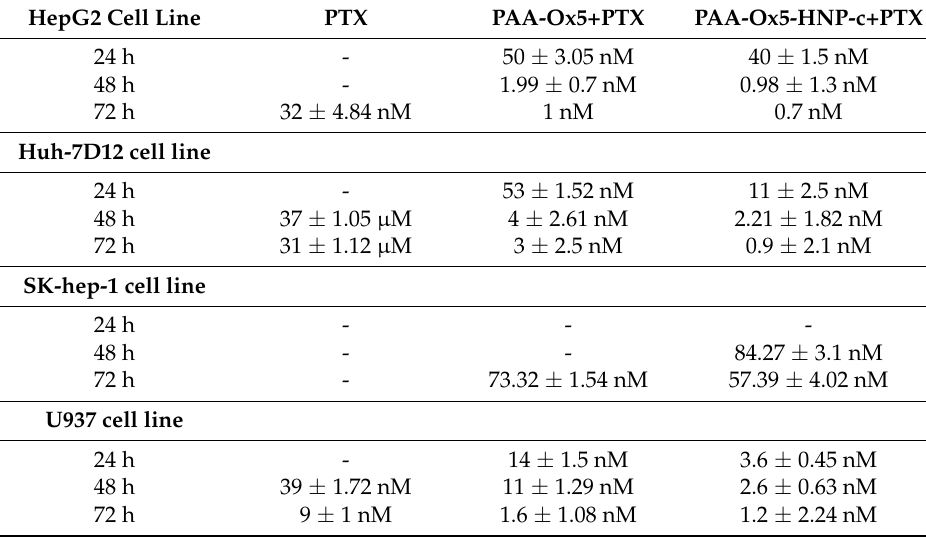
Table 2. IC 50 values observed over 24–72 h exposure of PTX alone and in formulation in